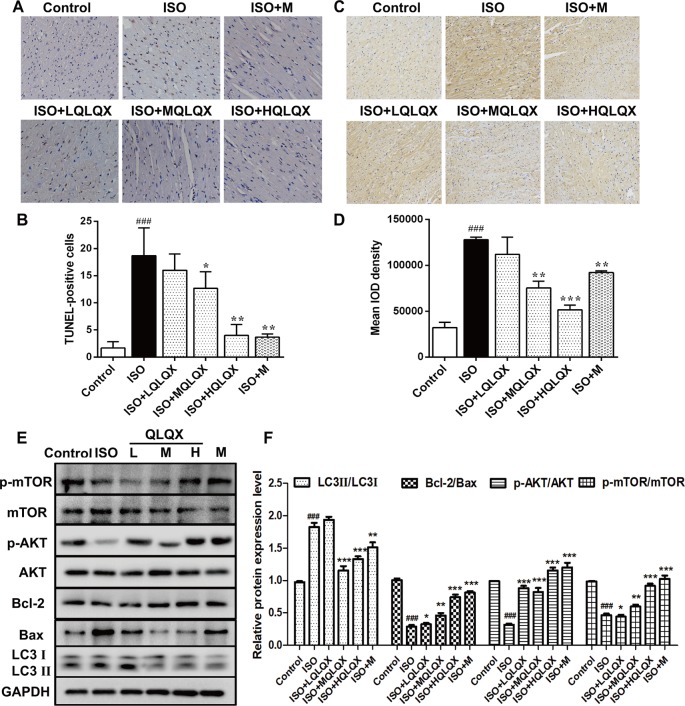
QLQX inhibits ISO-induced myocardial apoptosis and autophagy and involves in regulating the AKT/mTOR pathway in vivo. (A) Representative images of TUNEL staining (×400) for the different groups treated by ISO with or without QLQX. (B) Quantitative analysis of the proportion of TUNEL-positive cells. (C) Representative IHC images of LC3 in rats left ventricles (×100) for the different groups treated by ISO with or without QLQX. (D) Quantitative analysis of integrated optical density of LC3. (E) Representative western blotting bands of LC3I, LC3II, Bcl-2, Bax, p-AKT, AKT, p-mTOR, and mTOR and quantitative analysis of the ratios of LC3II/LC3I, Bcl-2/Bax, p-AKT/AKT, p-mTOR/mTOR by densitometry based on immunoblot images. Data are expressed as mean ± SD, n = 3. ###
p < 0.001 versus control group; *p < 0.05, **p < 0.01, ***p < 0.001 versus ISO group. ISO, isoproterenol; QLQX, Qi-Li-Qiang-Xin.